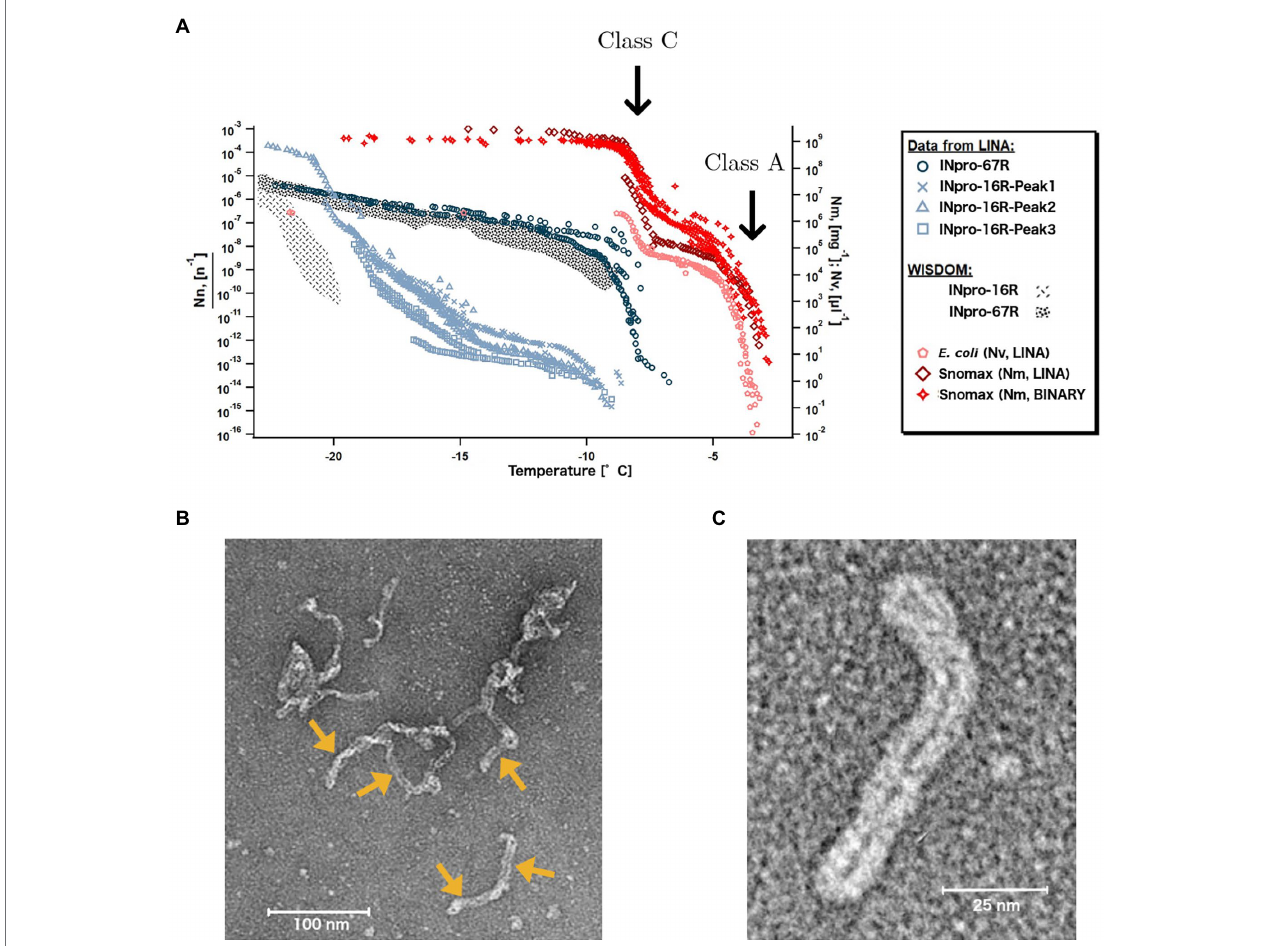
FIGURE 5 | Two types of INpro oligomers are responsible for the ice-nucleation activity of two INpro classes. (A) Ice nucleation activity of E. coli expressing INpro- 67R as well as of purified INpro-67R and INpro-16R proteins measured by the LINA setup. Presumed class A and class C characteristics and structures are indicated for E. coli and Snomax® ice nucleation spectra, but are also seen in INpro-16R spectra. Snomax® data were obtained from previous studies (Wex et al., 2015; Knackstedt et al., 2018). Data from WISDOM ice-nucleation measurements of INpro-16R and INpro-67R shown for comparison. (B) Representative negative stain TEM image of the INpro-67R showing highly oligomerized, filamentous structures. Individual filamentous structures, marked with yellow arrows, seem to assemble in an end-to-end manner into longer, higher order oligomeric assemblies. (C) Representative negative stain TEM image of an individual filamentous structure formed by